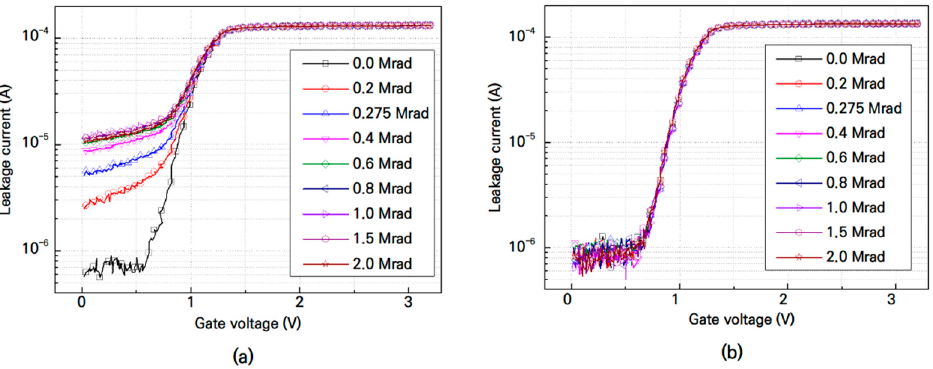
Figure 14. Leakage current measurements with respect to increasing cumulative doses ( a ) standard and ( b ) RH V-gate n-MOSFET.